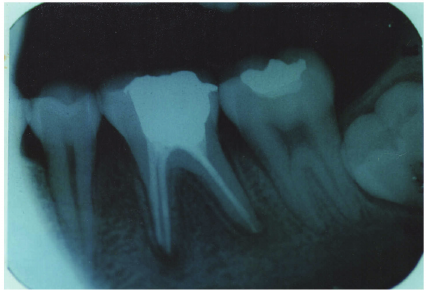
Figure 9: Obturation (46).